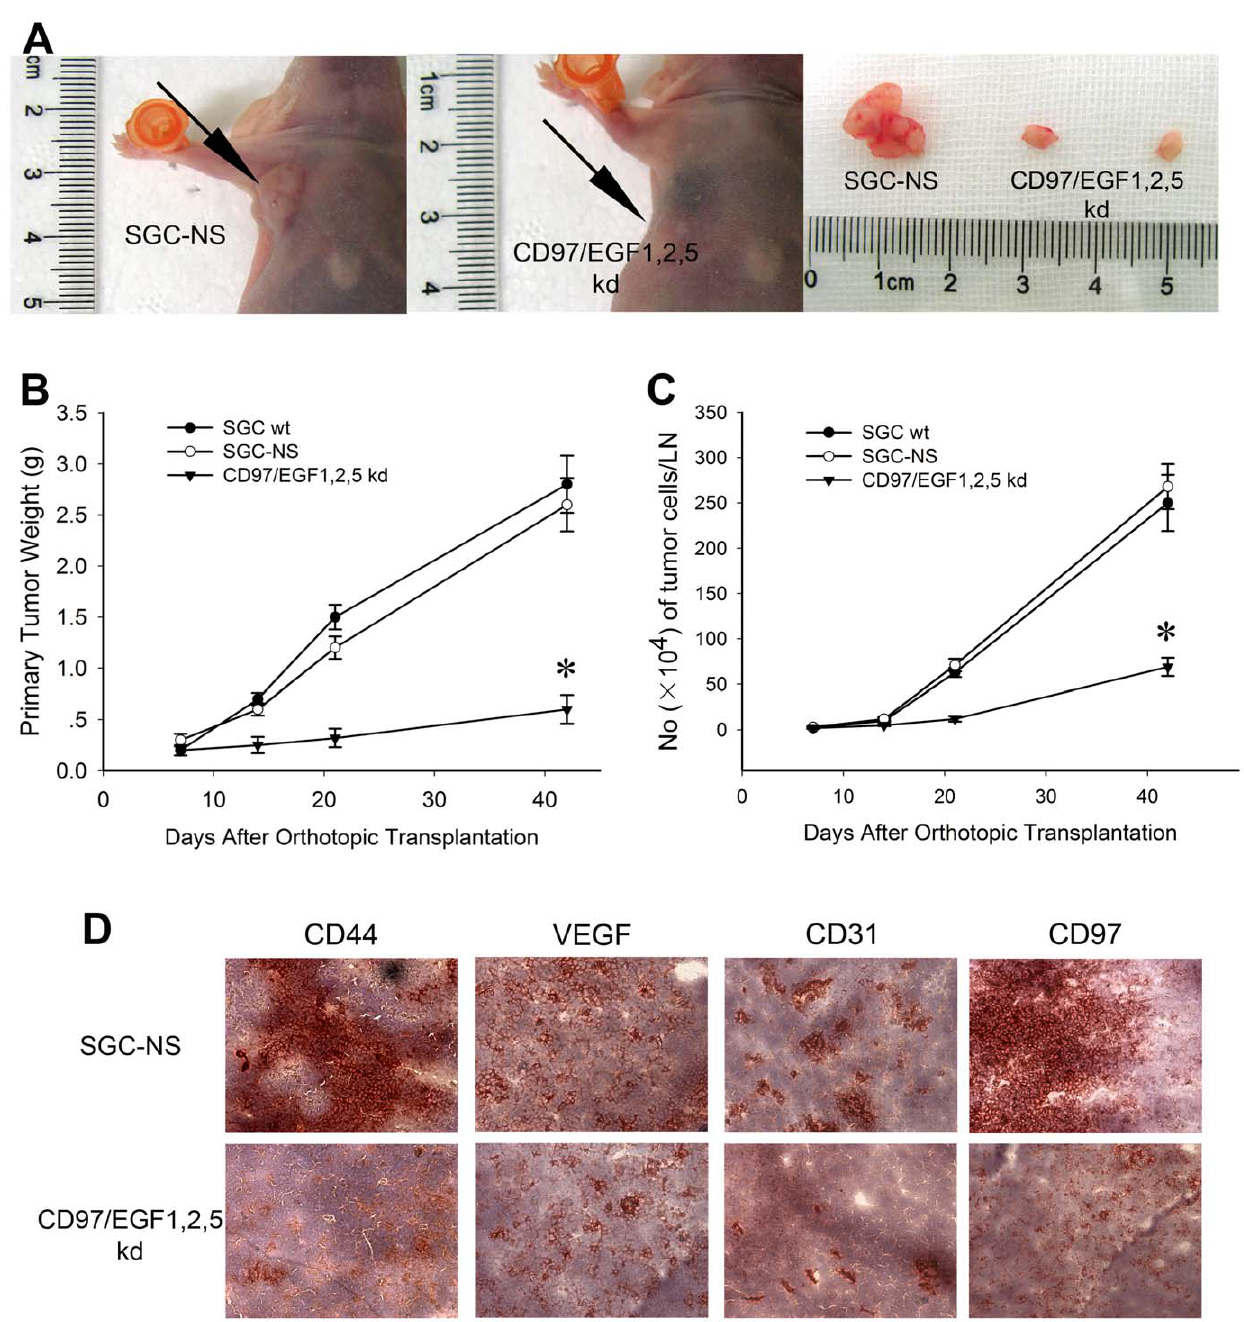
Figure 3. CD97 small isoform supports metastatic spread of orthotopically implanted gastric cancer. (A) The size of subcutaneous formed tumor masses of CD97/EGF1,2,5 kd group was significantly smaller. (B) Primary tumor weight of orthotopically transplanted gastric cancer in CD97/EGF1,2,5 kd group was significantly lighter (*p , 0.01). (C) The metastatic tumor cells within regional lymph nodes were counted by C4.4A staining and FACS (*p , 0.01). (D) Immunohistochemistry: CD44, VEGFR, CD31 and CD97 expression in early metastatic regional lymph nodes of CD97/ EGF1,2,5 kd group were strongly down regulated.